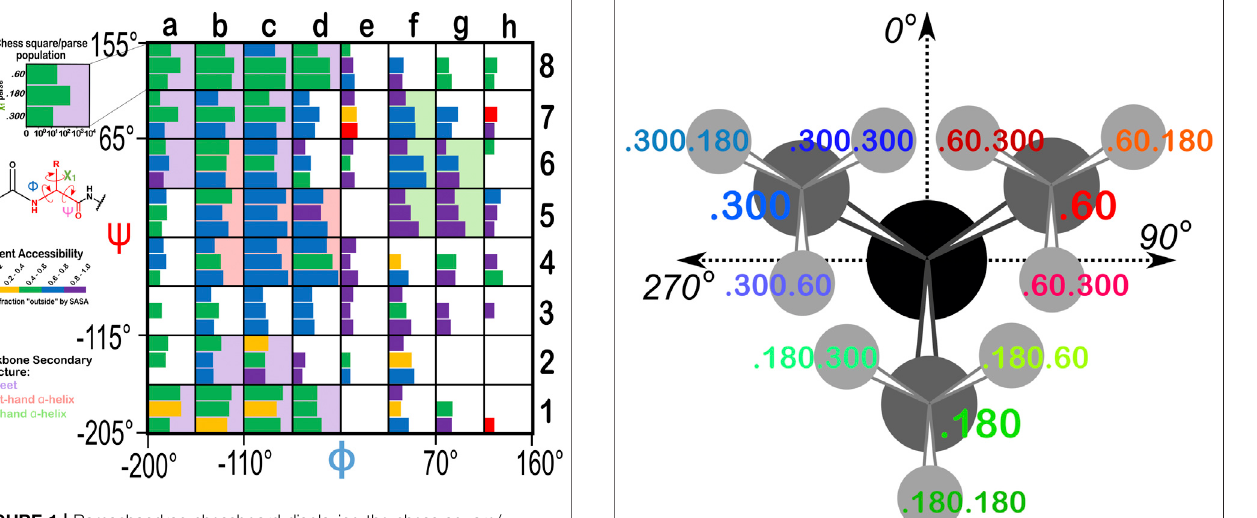
FIGURE 1 | Ramachandran chessboard displaying the chess square/ parsepopulationforasparticacid.TheRamachandran ϕ vs. ψ plotisrendered into 64 45 ° by 45 ° ( π /4 by π /4) chess squares. The ( χ 1 ) parse populations for ASP are represented in log 10 scale with the colored bars. Their colors re fl ecttheaverageweightedfraction outsideorsolventexposed,i.e., “ f outside ” , a measure of solvent accessibility (see text for de fi nition). The ϕ vs. ψ regions associated with β -pleat, α -helix, and left-hand α -helix secondary structure motifs are shaded in light purple, light orange and light green chess squares, respectively.